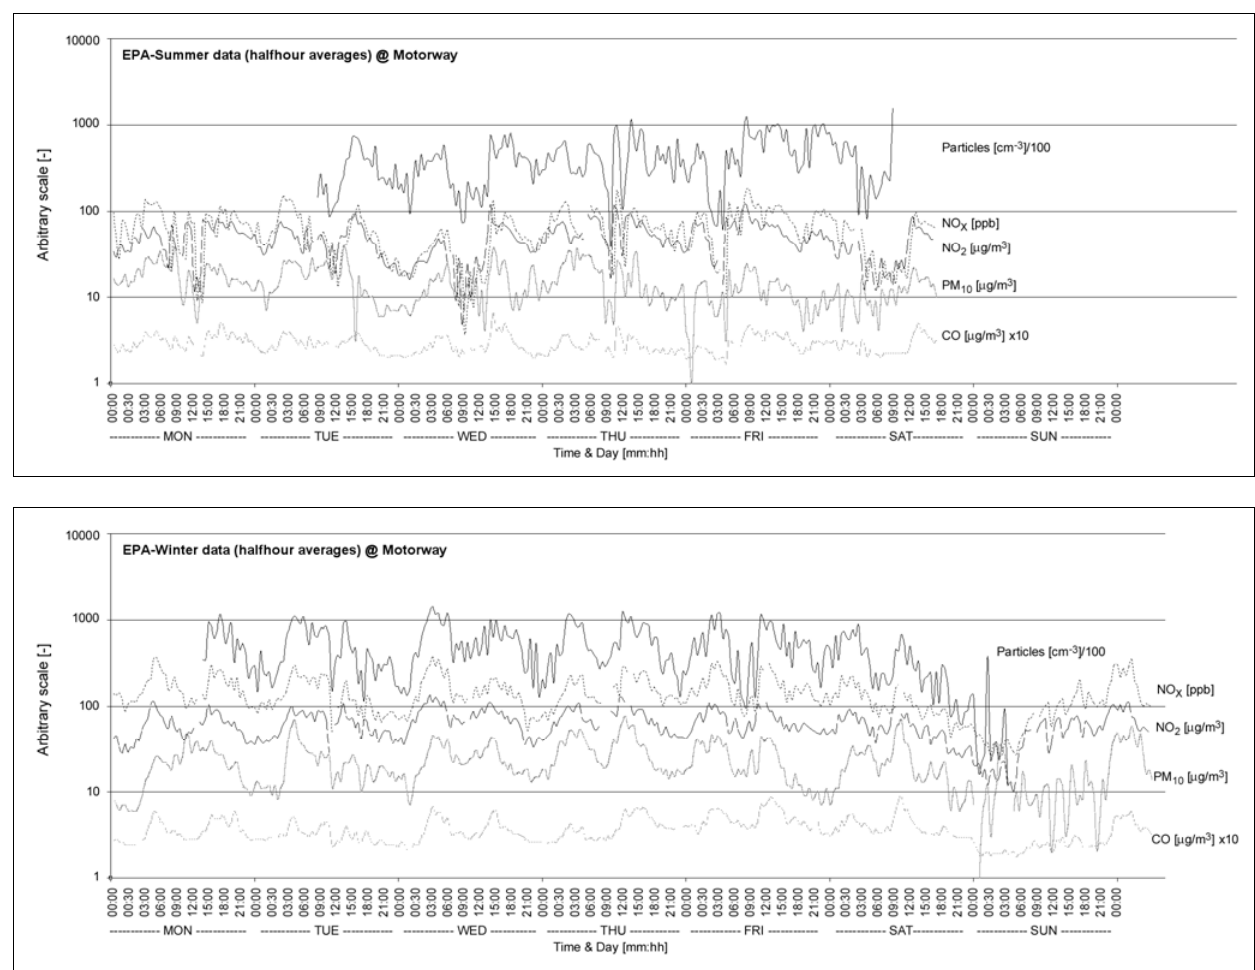
Figure 3. Environmental data (from EPA) as a time series; recorded over several days compared with ultrafine UFP number concentration at the motorway location for summer (upper panel) and winter ( lower panel)